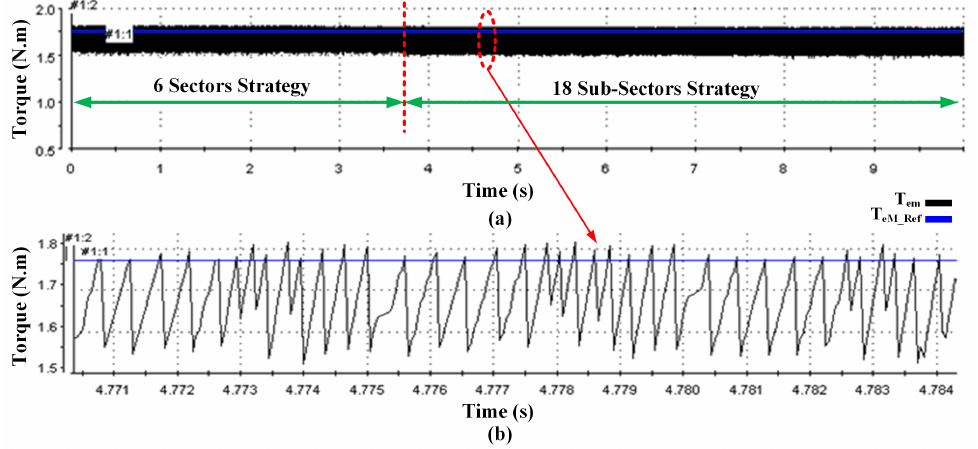
Figure 29. ( a ) Torque response towards VVs for the two strategies and ( b ) zoomed torque for 18-SS